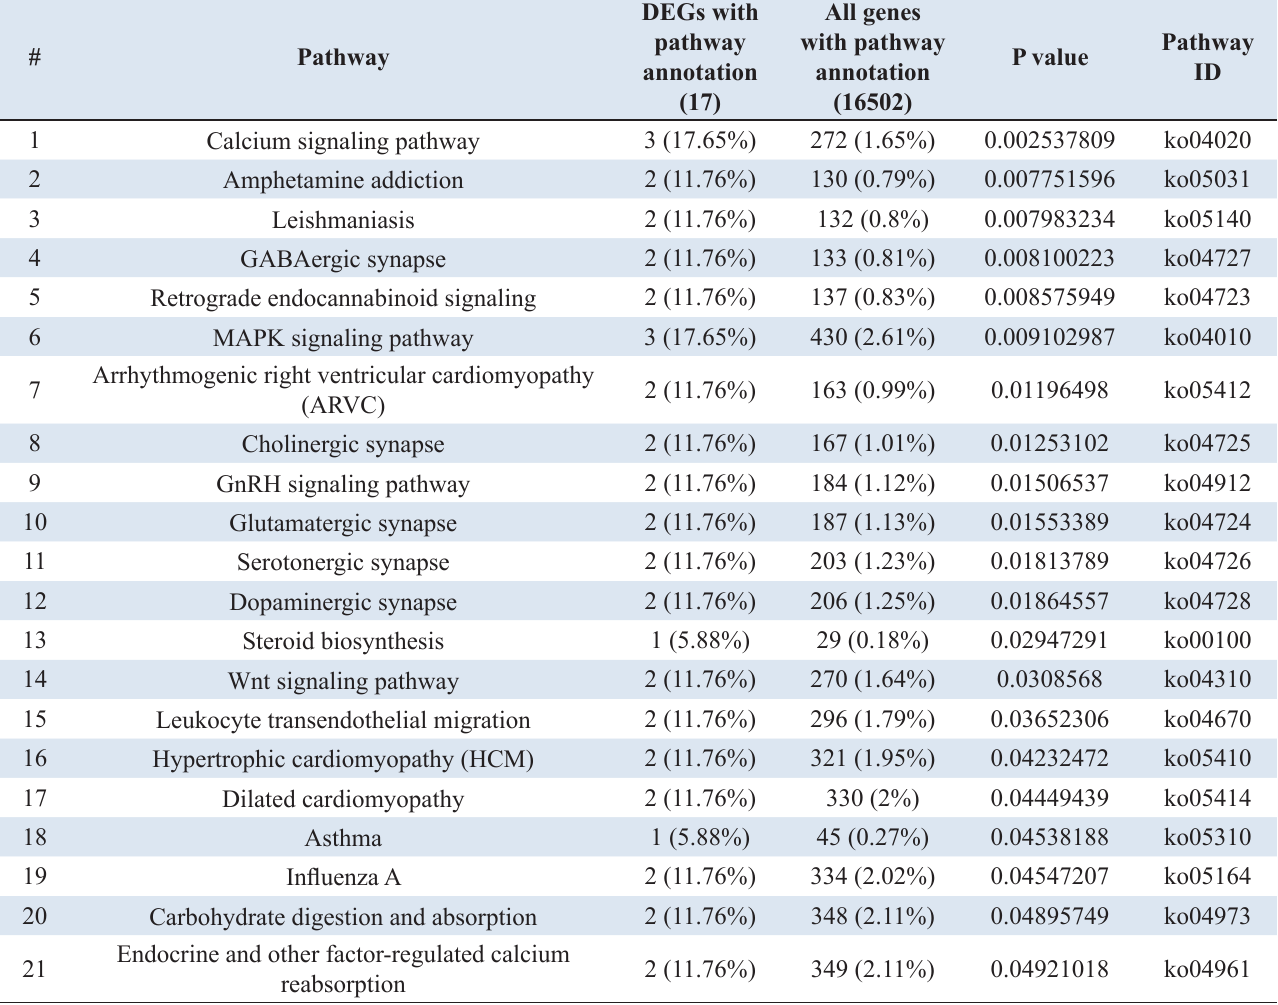
Table 2 . Pathway enrichment analysis of